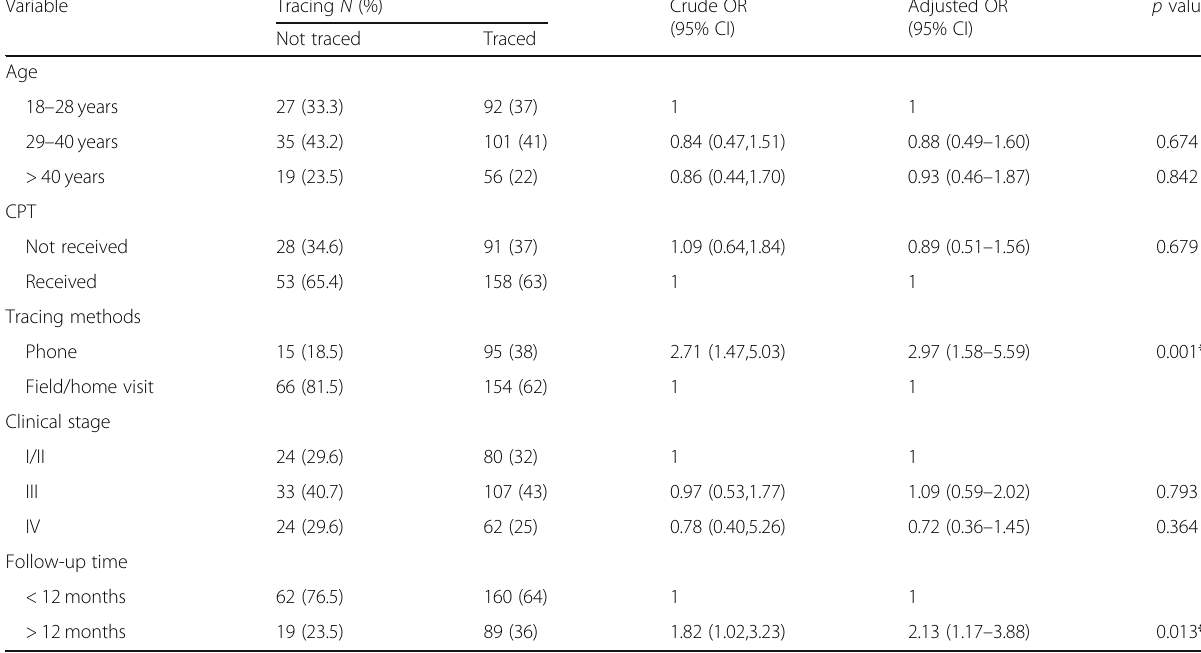
Table 3 Factors associated with successful tracing of LTFU adult HIV-positive patients Variable Tracing N